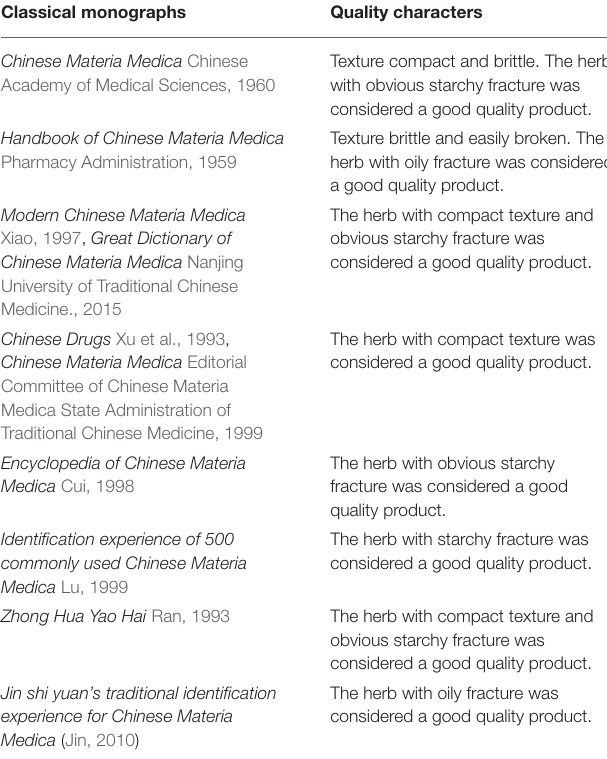
TABLE 3 | Quality characters of Isatidis Radix described in classical monographs on herbalogy and